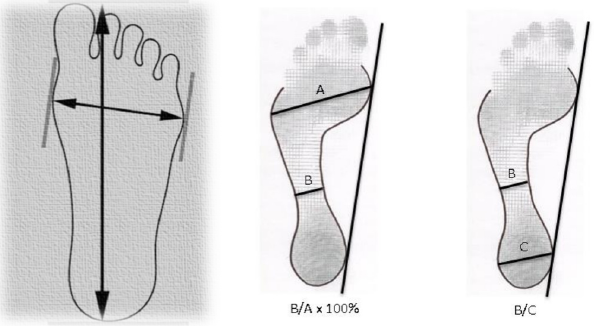
Figure 3. Measurements made on the footprints. ( A ) Length and width of the foot; ( B ) Chippaux– Smirak index; ( C ) Staheli index. Smirak index; ( C ) Staheli Figure 2. Study of the plantar footprint using the pressure platform.